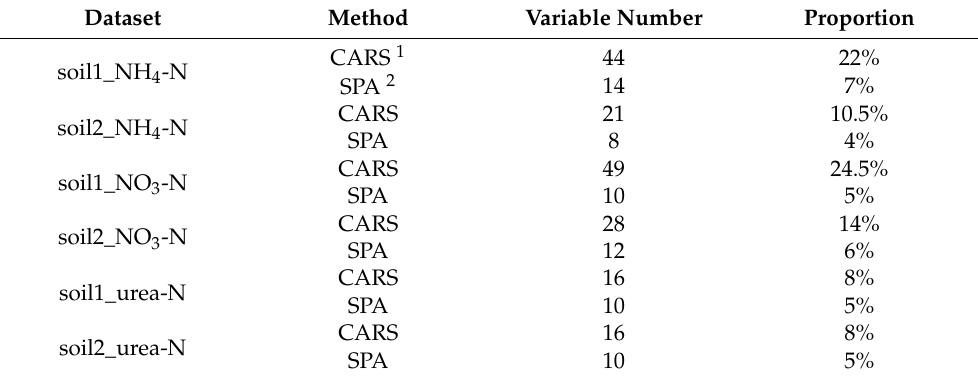
Table 3. Characteristic wavelength selection results based on CASR and